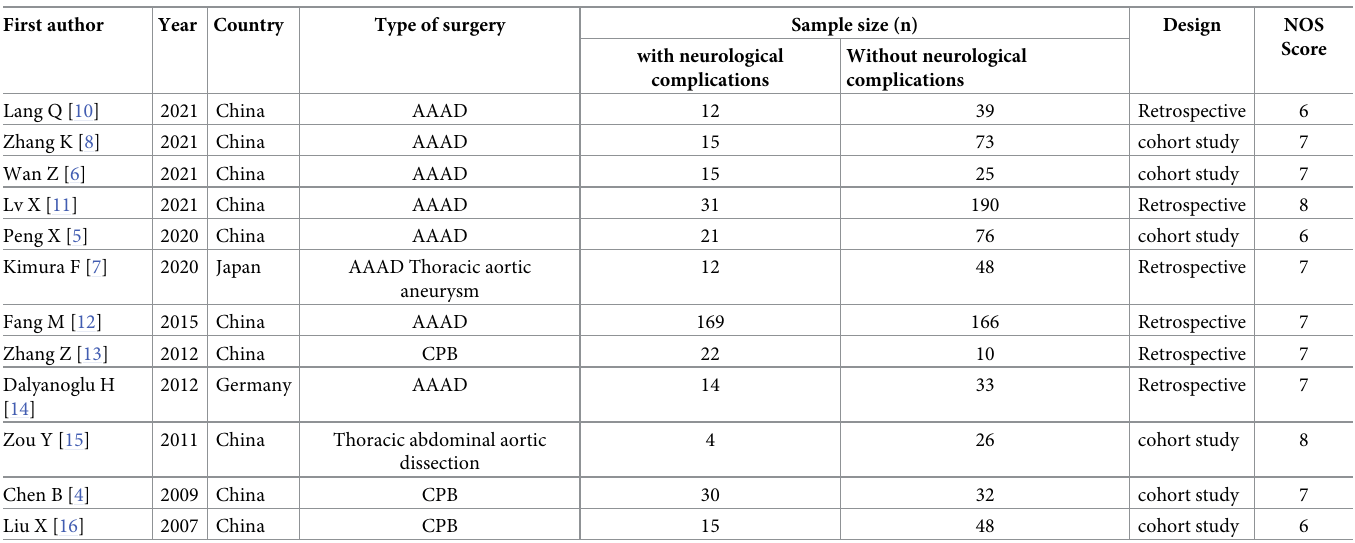
Table 1. Characteristics of all studies included in the